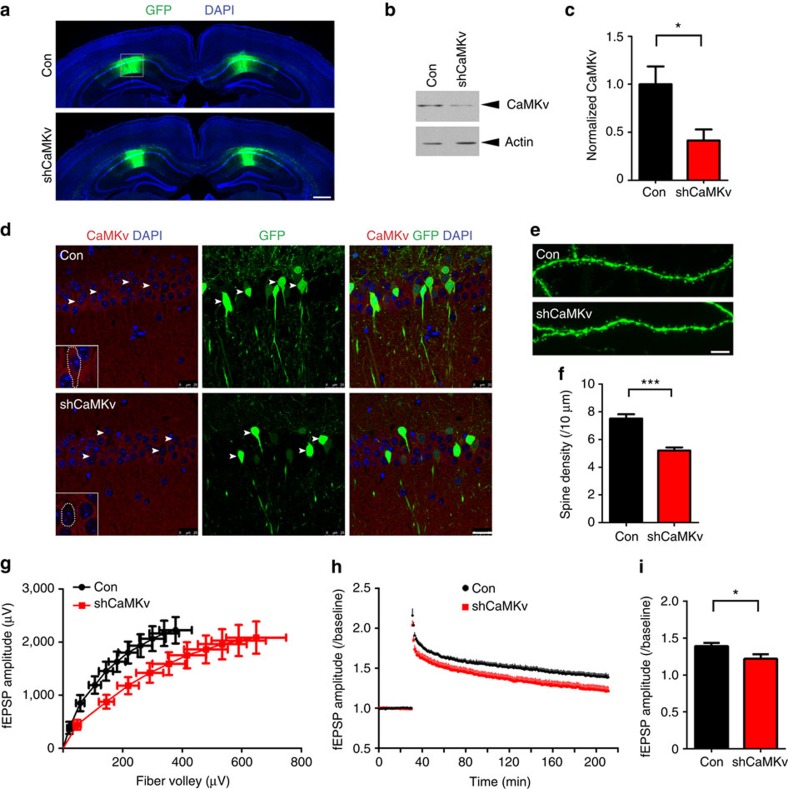
CaMKv knockdown in vivo reduces spine density and impairs basal synaptic neurotransmission and L-LTP.(a) Representative immunostained coronal sections from mice subjected to bilateral lentivirus injections (scale bar, 500 μm). (b,c) The indicated GFP-positive CA1 region was dissected to examine CaMKv levels. CaMKv knockdown (shCaMKv) in the hippocampal CA1 region significantly reduced CaMKv expression (Con: n=4 mice, shCaMKv: n=6 mice, *P<0.05, Student's t-test). (d) Hippocampal CA1 pyramidal neurons were transduced by control or lentiviral vectors expressing CaMKv shRNA. CaMKv knockdown in vivo reduced CaMKv expression (red) in CA1 neurons (scale bar, 25 μm; arrowheads: GFP-positive neurons; dotted area: magnified images of infected neurons). (e,f) CaMKv knockdown in vivo significantly reduced dendritic spine density. (scale bar, 20 μm; Con: n=34 dendrites, shCaMKv: n=21 dendrites, ***P<0.001, Student's t-test; green; GFP, red: CaMKv, blue: 4,6-diamidino-2-phenylindole (DAPI)). (g) CaMKv knockdown in hippocampal CA1 neurons inhibited basal synaptic neurotransmission. The input–output curve was altered in the infected CA1 region after CaMKv knockdown (Con: n=8 mice, shCaMKv: n=9 mice). (h) CaMKv knockdown impaired the L-LTP. (i) The field excitatory postsynaptic potential (fEPSP) amplitude (normalized to baseline) was significantly reduced in hippocampi injected with CaMKv shRNA (Con: n=8 mice, shCaMKv: n=9 mice, *P<0.05, Student's t-test).